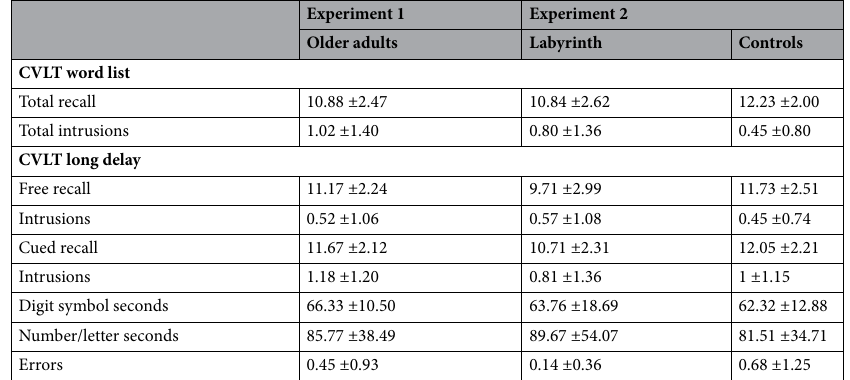
Table 1. Standardized cognitive assessments. Summary of participants’ mean scores in a selection of standardized cognitive assessments relevant to LTM, which were collected in a neuropsychological evaluation battery conducted within six months of study recruitment. All participants performed all tests in the neuropsychological battery at or above − 1.5 SD of age-normalized levels. These data are presented separately for the Older Adults in Experiment 1, and the Labyrinth and Controls arms in Experiment 2. There were no differences between the three groups in mean performance on any of the tested cognitive